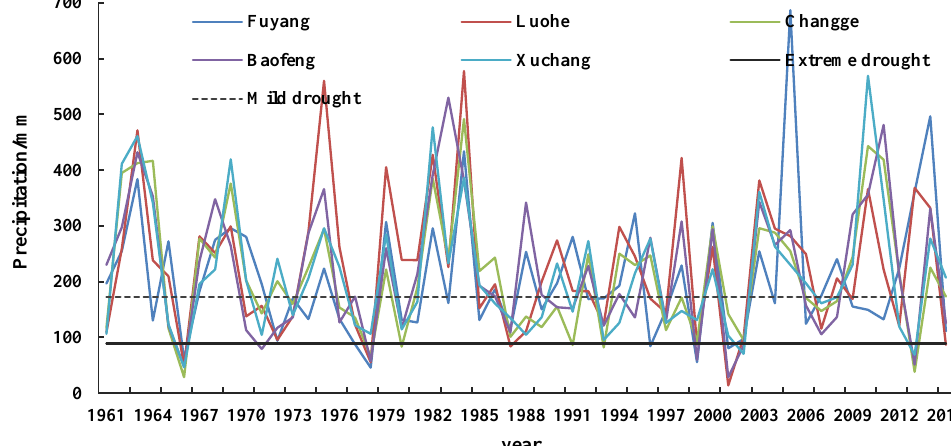
Figure 8. Variation in precipitation during the critical water period during summer maize growth at typical sites from 1961 to 2015.